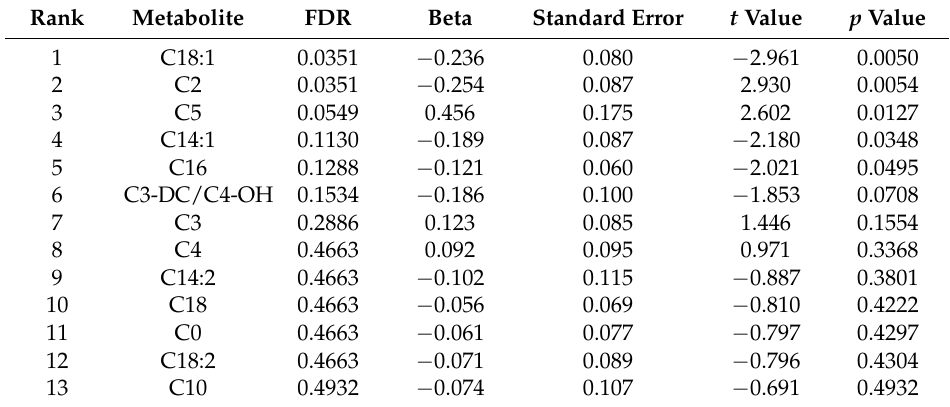
Table 4. Data adjustment based on a linear mixed model (regression analysis).